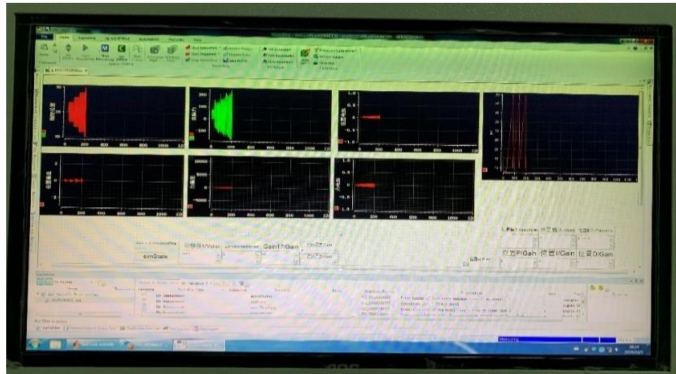
Figure 16. Signal acquisition interface.